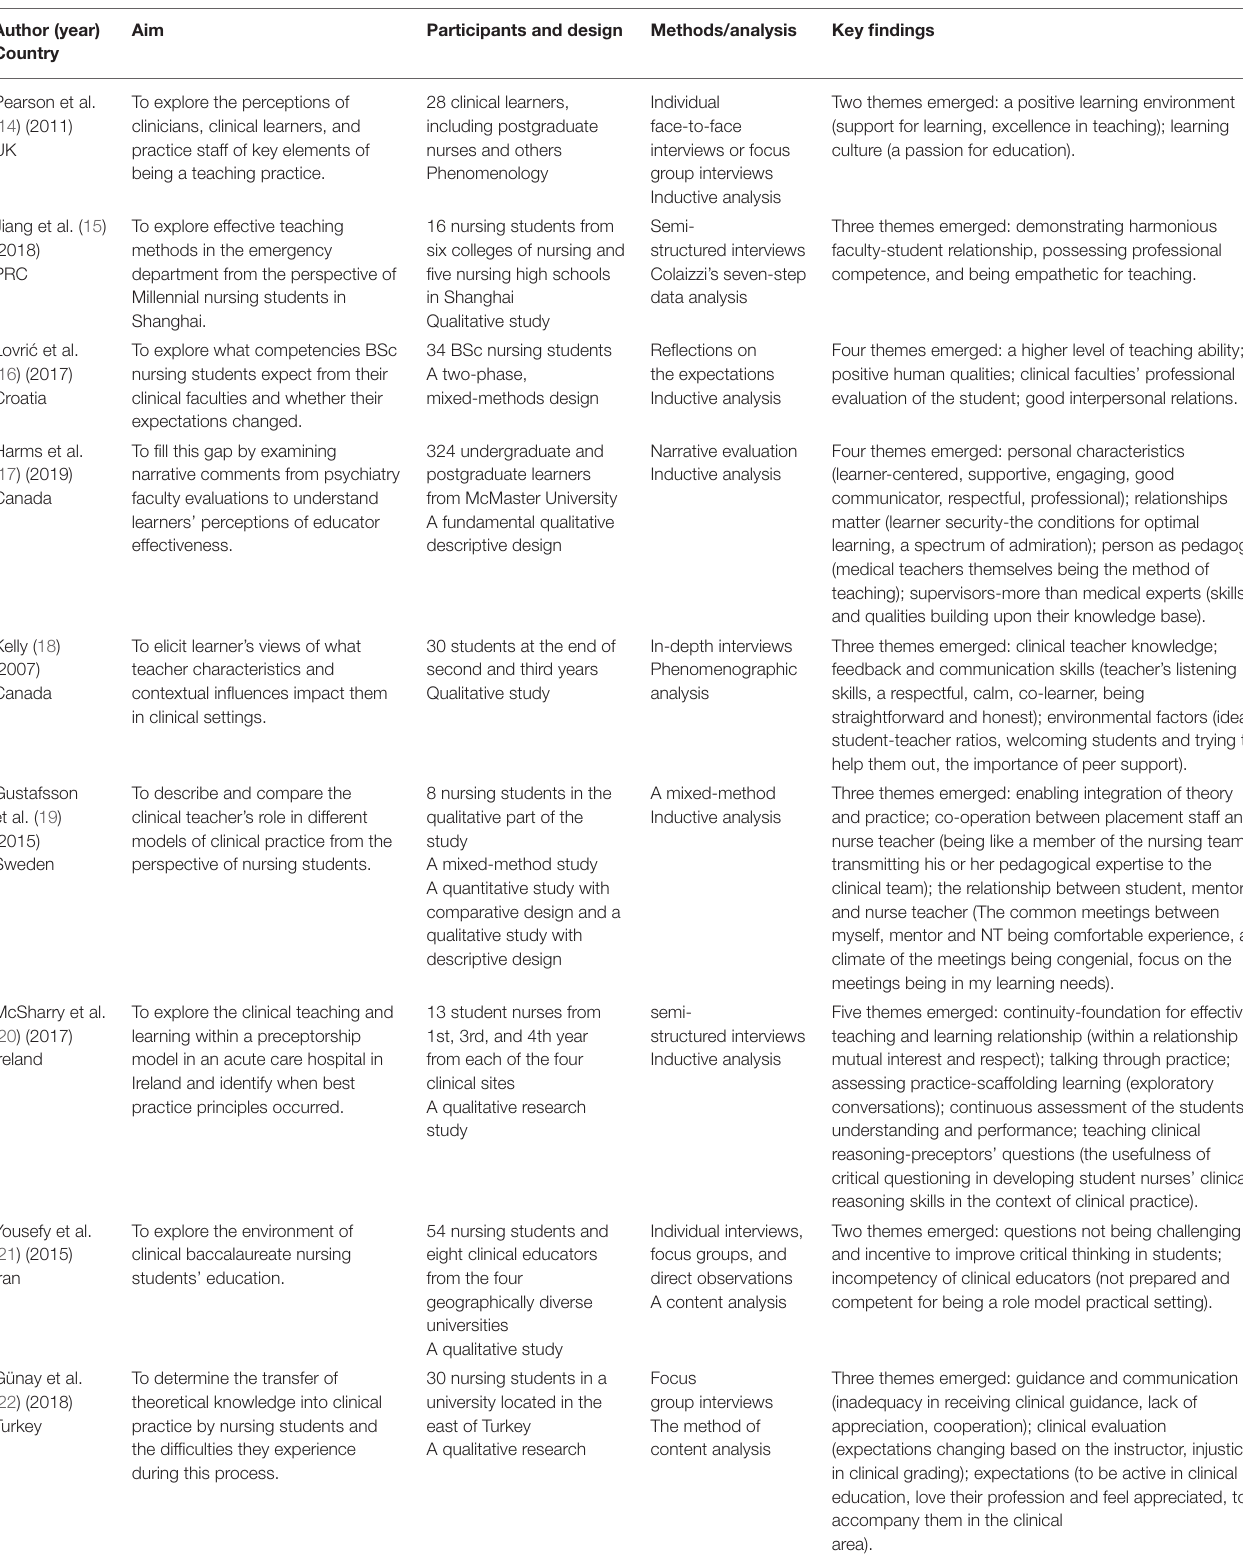
TABLE 2 | Meta-summary of included